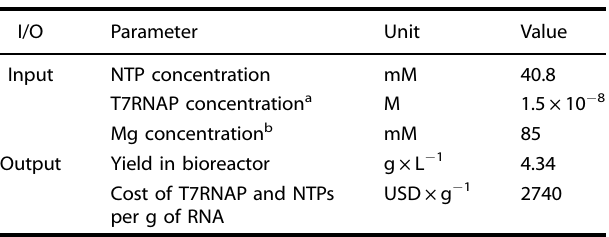
Table 2. Key modelling input and output